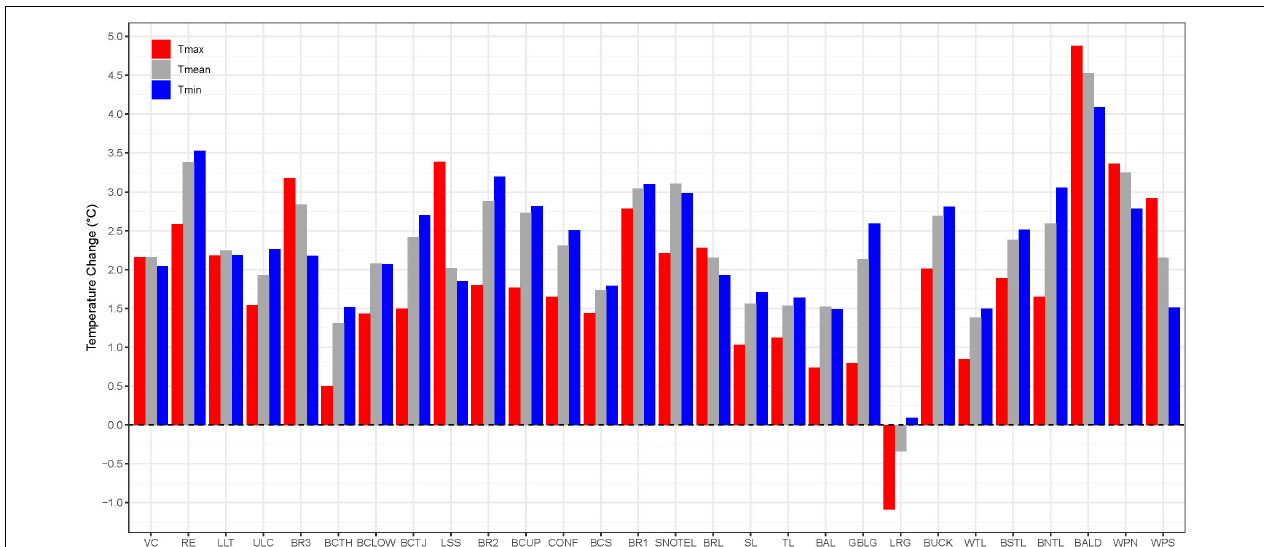
FIGURE 8 | Overall study period temperature changes from 2006–2018 at each sensor location, arranged by elevation. Changes of maximum temperature (red), mean temperature (gray), and minimum temperature (blue) were calculated using linear regressions of daily temperature values.